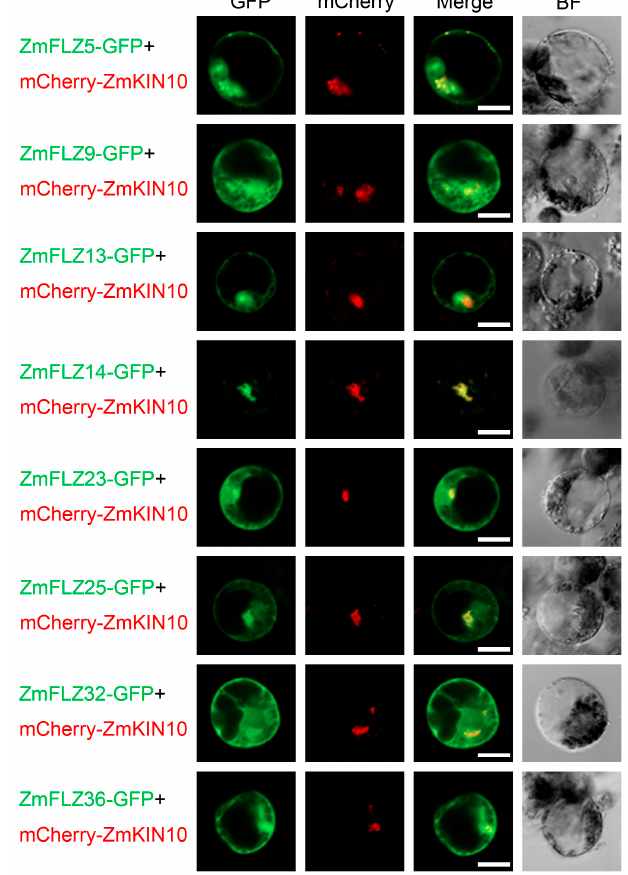
Figure 4. Co-localization analysis of ZmFLZs and ZmKIN10 in maize leaf protoplast cells. Co-expression of mCherry-ZmKIN10 and the GFP fused ZmFLZs in protoplasts followed by confocal imaging. Fluorescent images of GFP and mCherry were captured with a confocal laser scanning microscopy and shown in green and red, respectively. Scale bars = 25 μ m.